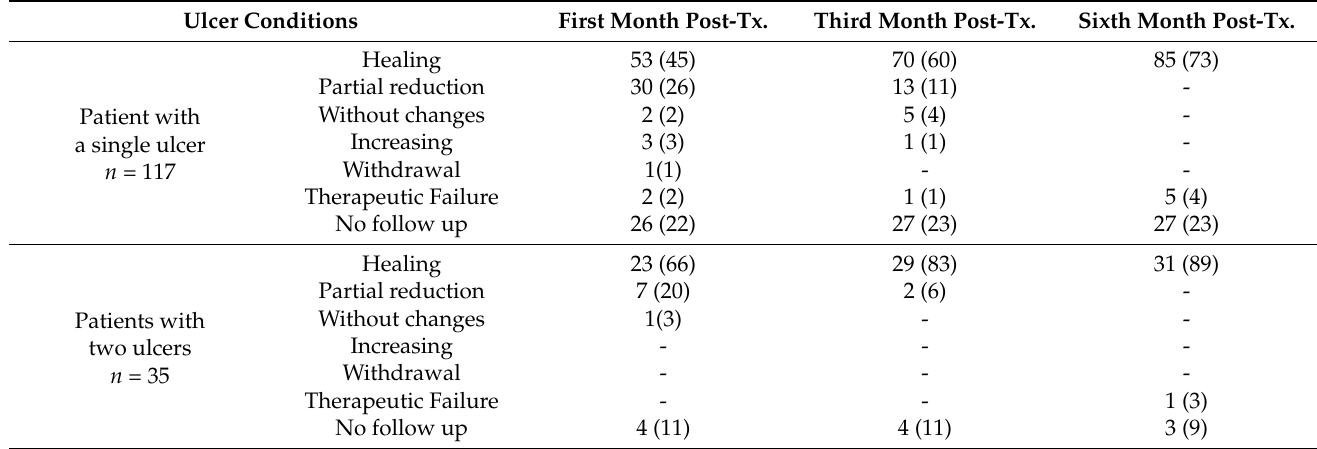
Table 3. Patients with single or two ulcers and their conditions during clinical follow-up after treatment with intralesional meglumine antimoniate. Data presented as frequencies (%). Ulcer Conditions First Month Post-Tx. Third Month Post-Tx. Sixth Month